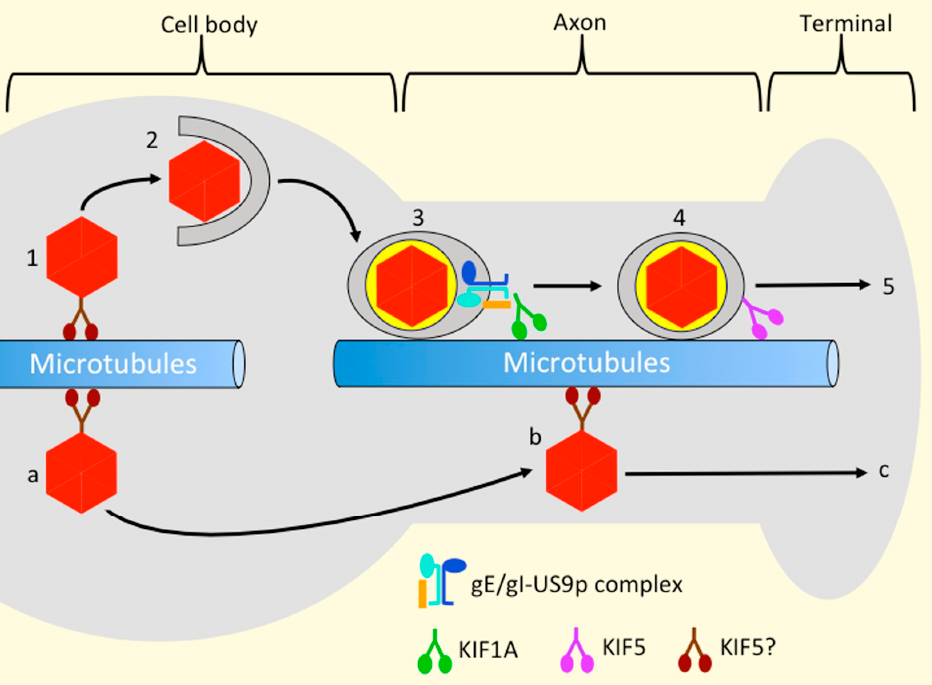
Figure 3. The Married and Separate models for alphaherpesvirus egress in neurons, and possible roles for kinesins KIF1A and KIF5 during transport. Steps 1–5: Married model. ( 1 ) After emerging from the nucleus, packaged capsids (red hexagons) recruit kinesin motors (shown in brown, possibly isoforms of KIF5 as detailed in Figure 2a to traffic through the cytoplasm of the cell body). ( 2 ) Upon reaching their site of envelopment, capsids bud into the organellar lumen to generate a mature OEV. ( 3 ) The OEV (depicted as in Figure 2b utilizes the gE/gI-US9p apparatus (blue lollipops and orange bar) to recruit KIF1A (shown in green), and ensure its delivery from the cell body into the axon. ( 4 ) Upon reaching the axon, the OEV may recruit isoforms of KIF5 (shown in purple) for subsequent transport, and either retains KIF1A or targets it for destruction (see text for details). ( 5 ) Kinesin-mediated transport eventually delivers the OEV to the nerve terminal for subsequent exocytosis and spread. Steps ( a – c ): Separate model. ( a ) Capsids utilize kinesin motors and MTs to travel through the cell body cytoplasm and into the axon. ( b ) Non-enveloped capsids travel along the axon, though the identity of the kinesin(s) used at this stage remains unknown. ( c ) After arriving at the nerve terminal, the capsid acquires its envelope by a process similar to that in step 2, and infectious virions are released by